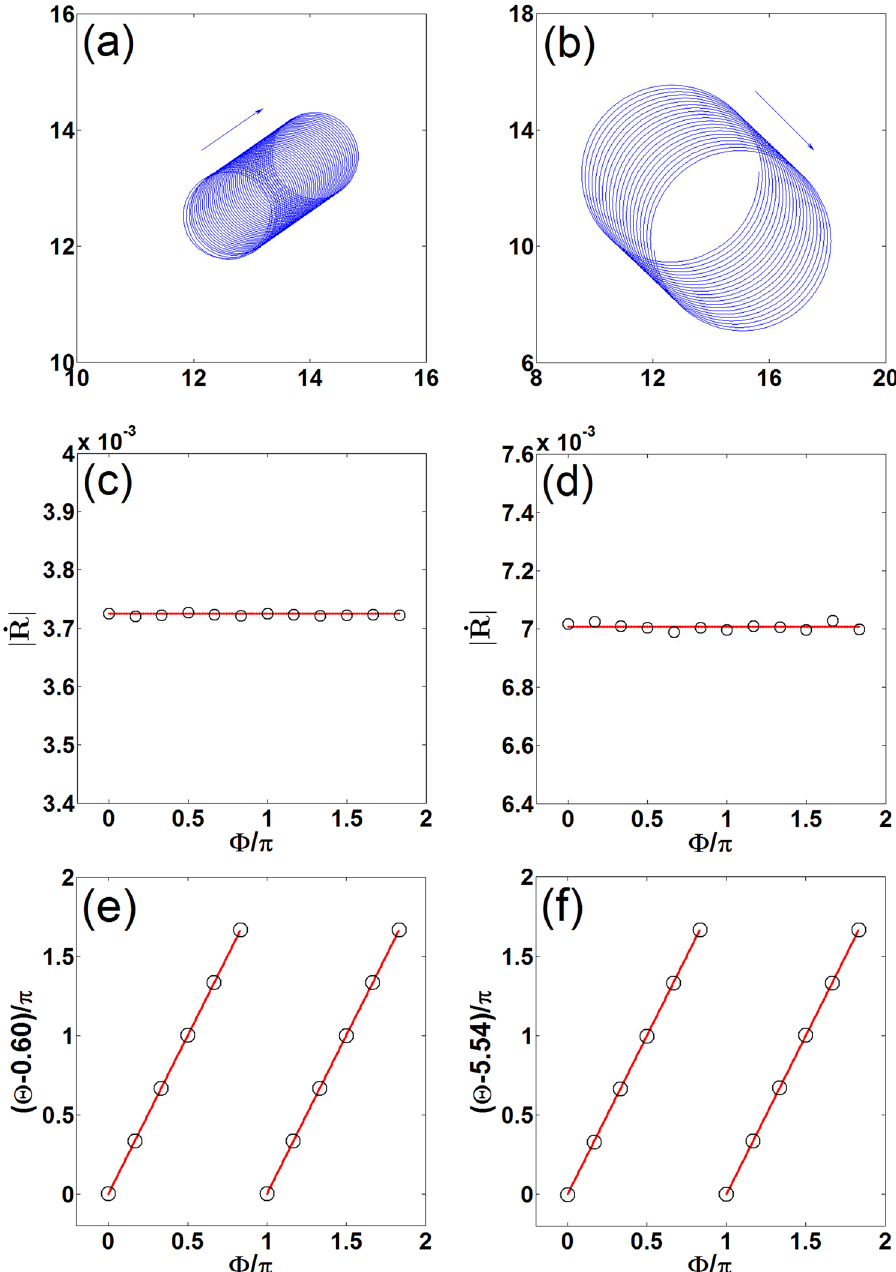
Figure 2. First row: Trajectories of spiral tips movement under the influence of an ac electric field with ω e = 2 ω , = 0, and Φ = 0. Second row: Drift speed as a function of Φ with φ φ e of Φ with φ e = 0. In the second and the third rows, the circles represent numerical simulations and the lines represent theoretical predictions. Left column: Highly excitable medium. Right column: Weakly excitable